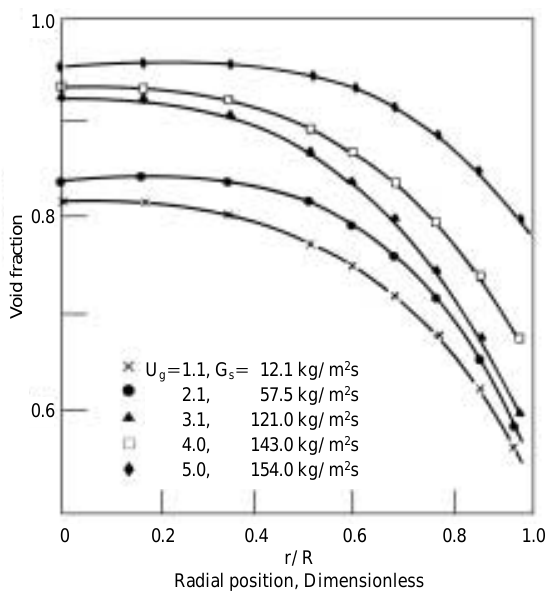
Radial variation of void fraction at different velocities, open valve